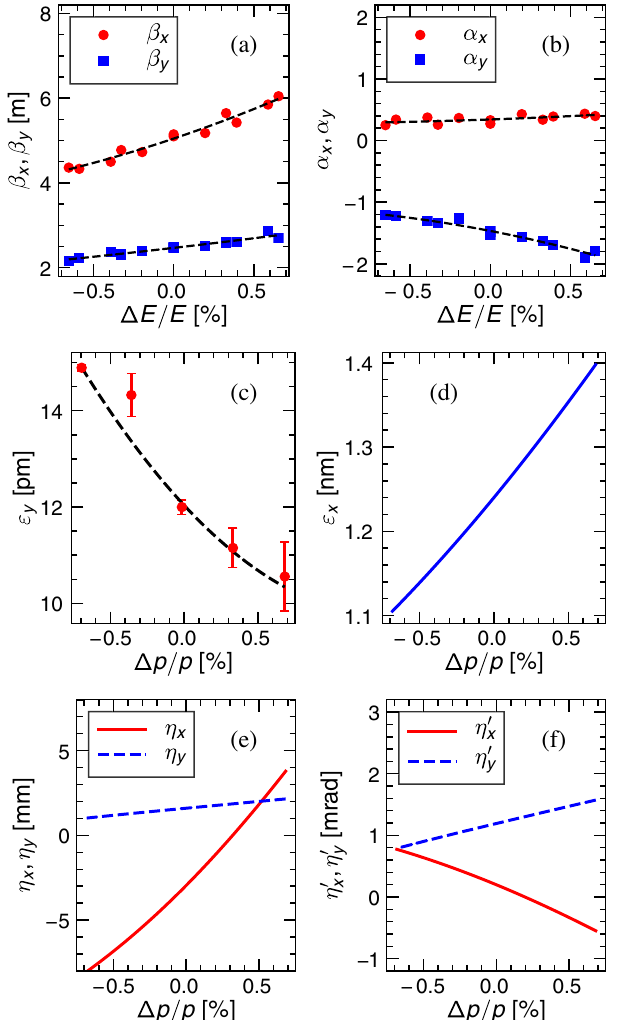
FIG. 6. Chromatic Twiss parameters (a, b), emittances (c, d) and dispersion functions (e, f) at the extraction. The Twiss parameters and vertical emittance are from measurement while the others are predicted through simulation. The dashed lines in (a – c) are fits to the experimental data.